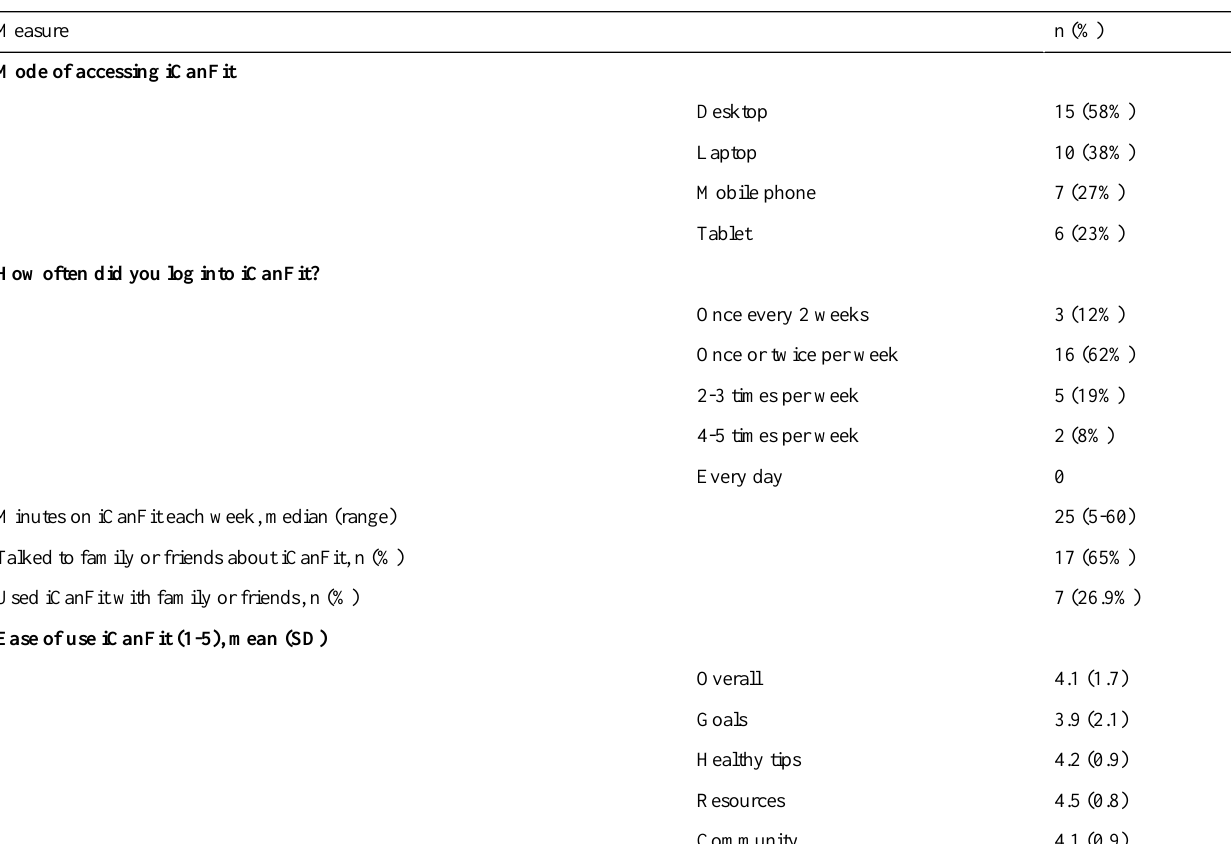
Table 2. User experience with iCanFit (follow-up,